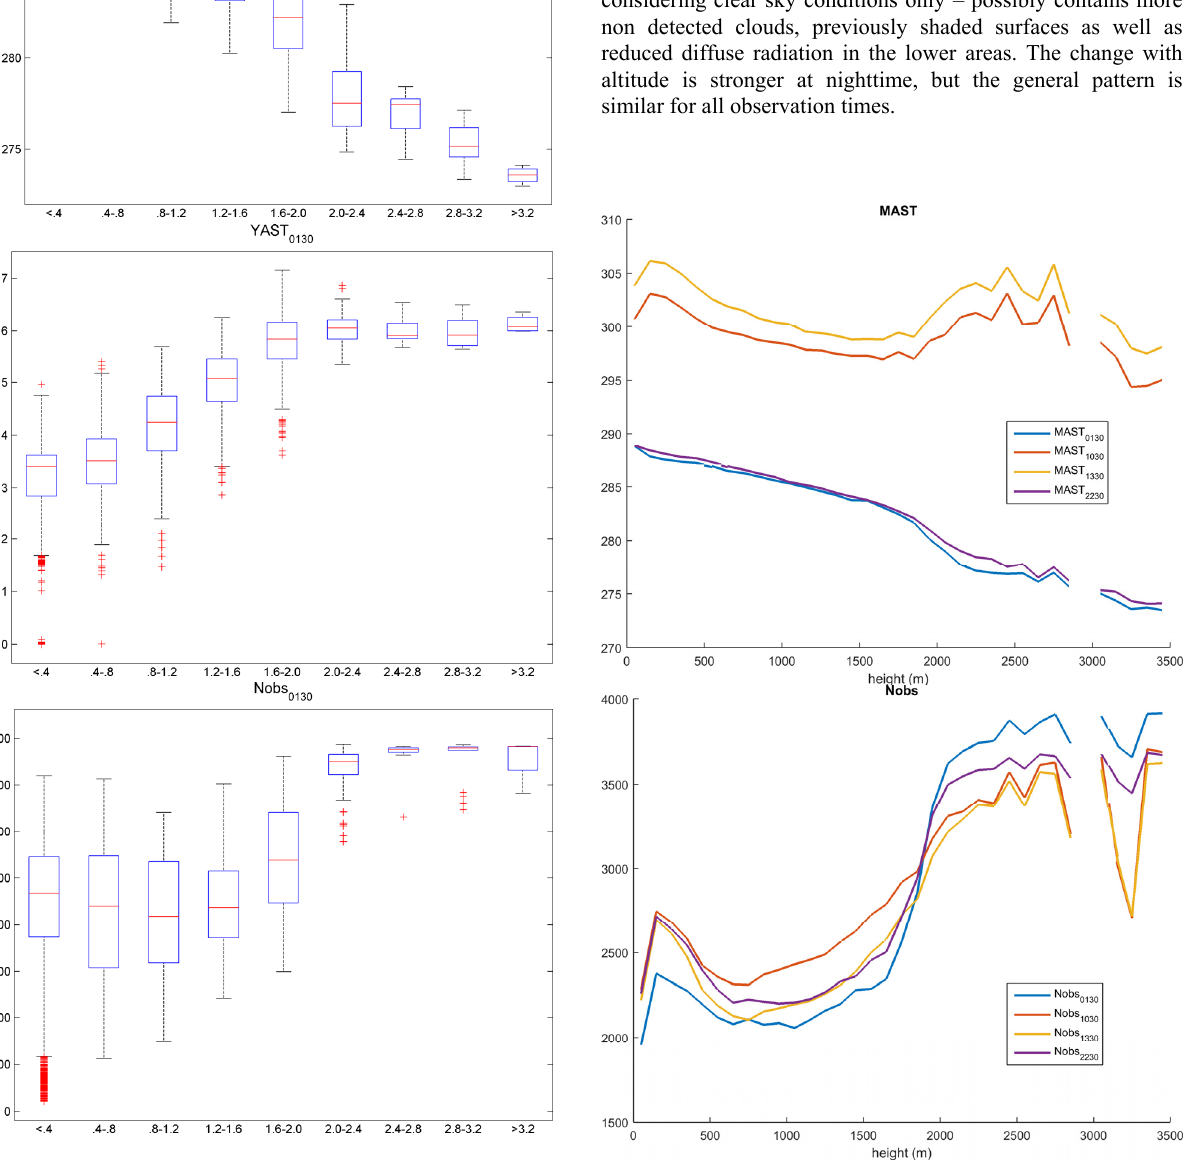
Figure 10. Mean annual surface temperature in K, and number of observations at different acquisition times and height levels (means of 100 m